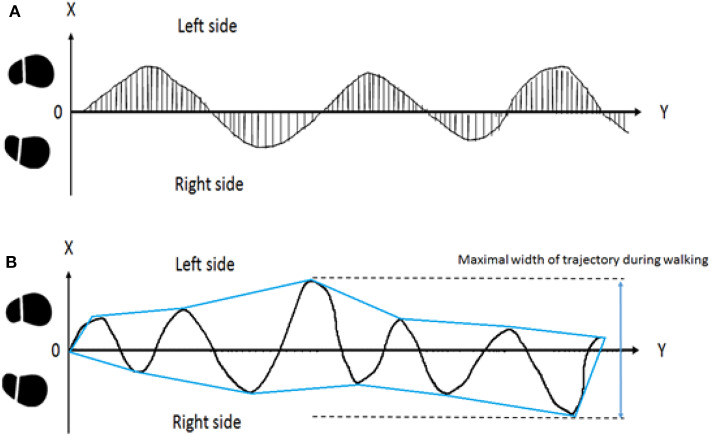
Illustration of walking trajectories. In the upper subplot (A), displacement from the midline of each sample was averaged and normalized as the parameter of body stability during walking. The X displacement of the center of the body (XCoB) represents the deviation of the trajectory during FW and BW. In the lower subplot (B), the enveloping line was placed over the trajectory. The maximal width from right to left was considered as sway during walking.